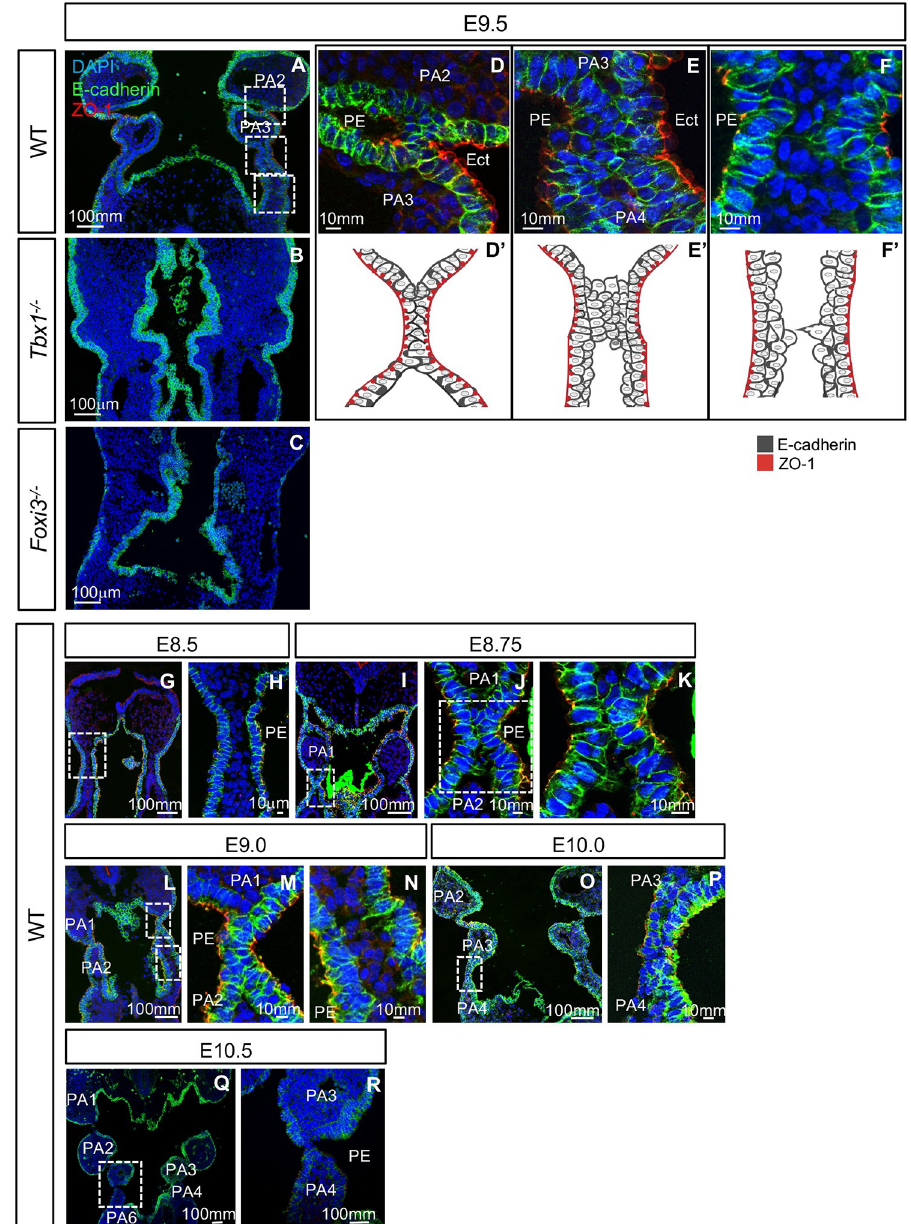
Fig 5. PA segmentation in wildtype, Tbx1 and Foxi3 mutant embryos. (A-F) To visualize epithelial cells within the PA, DAPI (blue), E-cadherin (green), and ZO-1 (red) antibodies were used for immunofluorescence on WT (A), Tbx1 -/- (B), and Foxi3 -/- (C) coronal sections at E9.5 (WT, n = 5; Tbx1 -/- , n = 4 and Foxi3 -/- , n = 5). White boxes (A) indicate where the region was magnified (D-F). (D) Second pouch and cleft where segmentation is complete and epithelial cells formed a dual intercalated layer. (E) Third pouch and clefts are forming at E9.5. The epithelium is stratified. (F) Location of future PA4-PA6, where invagination is initiated, as can be observed by cell projections from the epithelia. PE indicates the pharyngeal endoderm and Ect. indicates the ectoderm for each section. (D’-F’) Cartoon illustrating the segmentation process from images in D-F. (G-R). DAPI (blue), E-cadherin (green), and ZO-1 (red) antibodies were used for immunofluorescence to visualize epithelial cells within the PA in coronal sections from WT E8.5 (G-H), E8.75 (I-K), E9.0 (L-M), E10.0 (O-P), E10.5 (Q-R) embryos. White boxes indicate the location of higher magnification images. PE indicates pharyngeal endoderm; n = 4 for each stage.